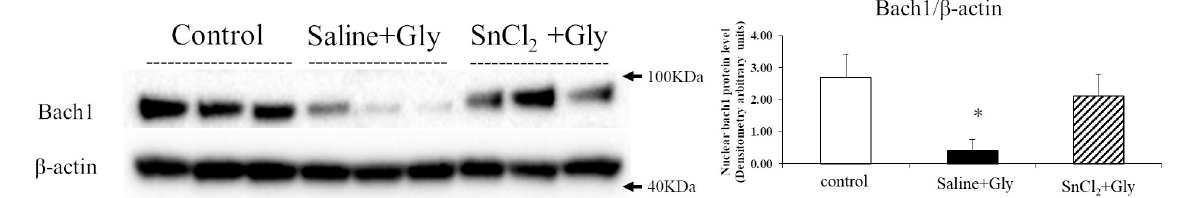
Fig 8. Renal nuclear Bach1 protein expression levels 3 h after Gly treatment. Rats pretreated with saline or SnCl 2 (s.c.) were sacrificed 3 h after Gly treatment (10 mL/kg of 50% glycerol, i.m.), and renal tissues were collected for western blot analysis. Control, untreated control rats; saline+Gly, saline-treated before Gly-treated rats; SnCl 2 +Gly, SnCl 2 -treated before Gly-treated rats. The densitometric ratio between Bach1 and β -actin was calculated. Data are expressed as the mean ± SD. � p < 0.05 vs control group.